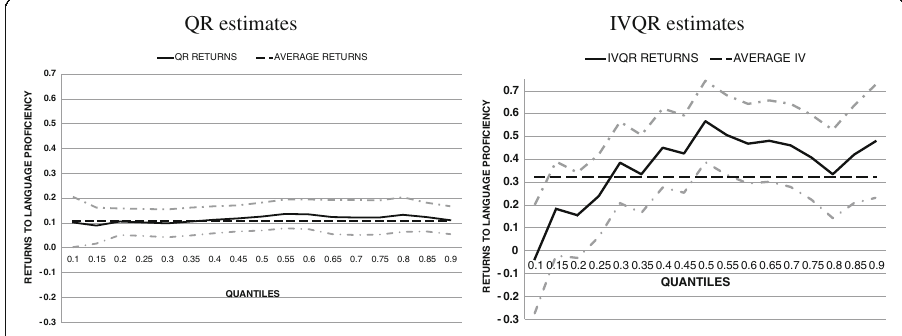
Fig. 2 QR and IVQR estimates — workers with at least upper secondary education. Note: (i) dotted line in QR returns denotes non-significant at those quintiles, (ii) upper and lower curves comprise the 95% confidence interval, and (iii) models with occupation